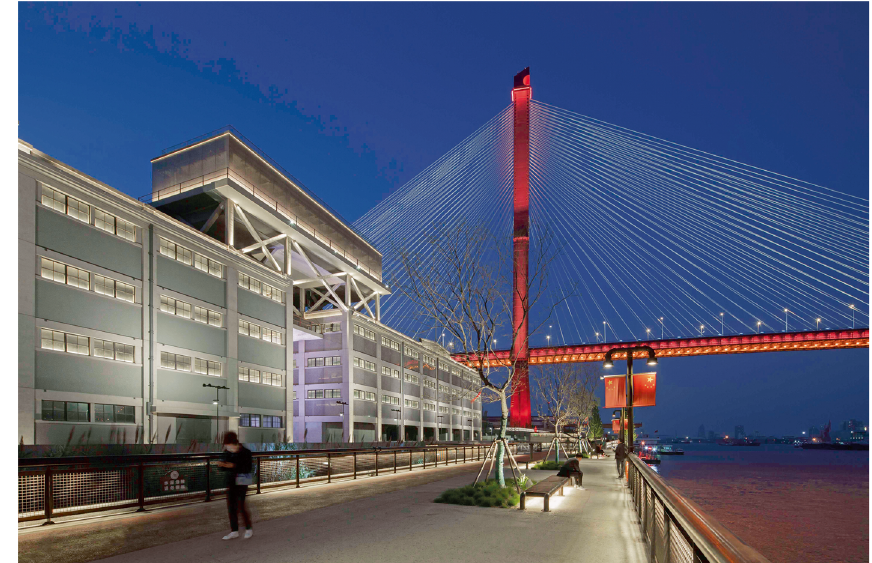
Fig. 14 Walking path along the river (Source: Tianzhou Yang)